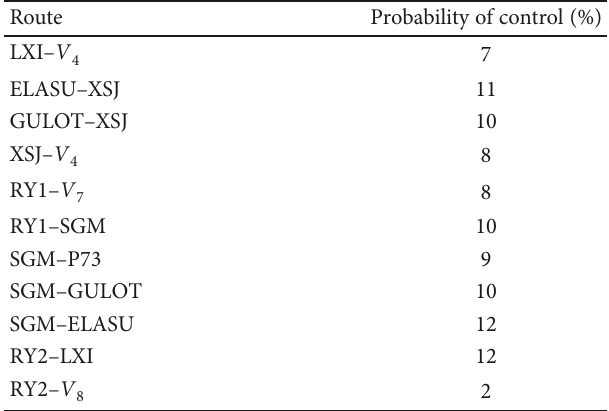
Figure 9: Terminal airspace under weather condition (b). Table 7: Distribution of control preference for each route of the sector